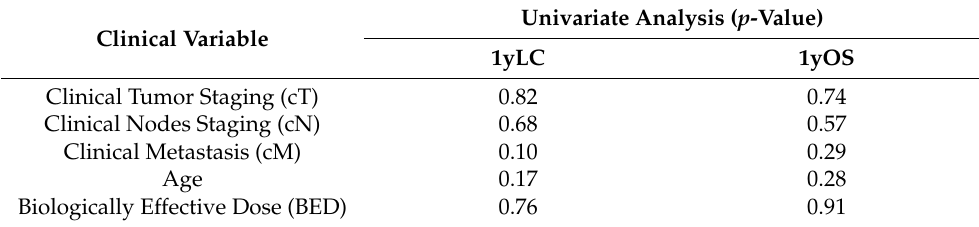
Table 3. Results of the univariate analysis performed using the Wilcoxon Mann–Whitney (WMW) test between five clinical variables (cT, cN, cM, age, and BED) and two outcomes (one-year local control, 1yLC; and one-year overall survival,